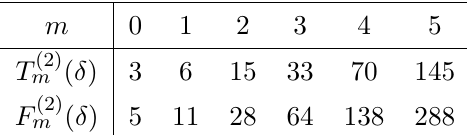
Table 5 . Number of coefficients in the ansatz for T (2) m ( δ ) and F (2) m ( δ )